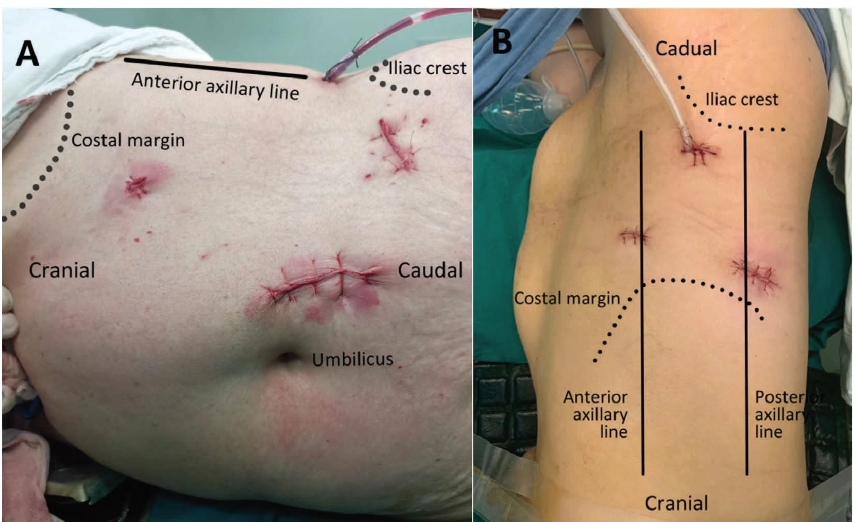
Figure 2: Incisions in the laparoscopic partial nephrectomy. (a) Transperitoneal approach; (b) retroperitoneal